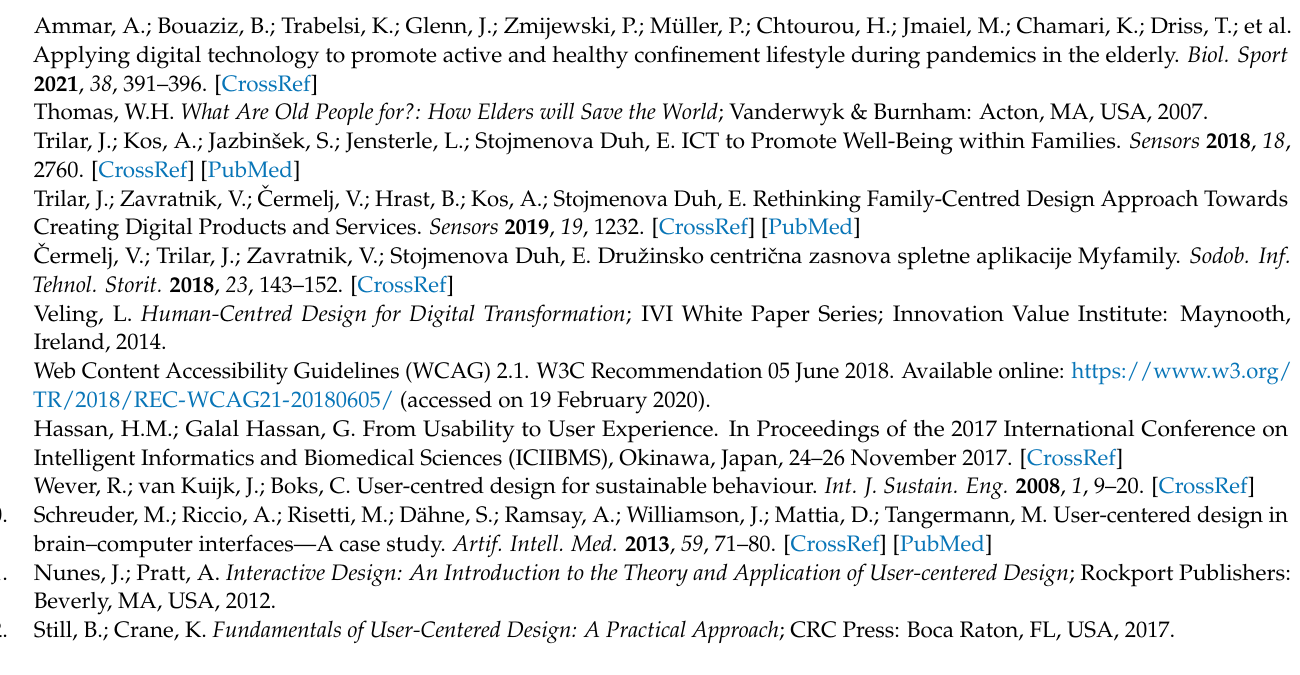
1, Table S26: Success rate by interface for Generation 2, Table S27: Time on task by interface for Generation 2, Table S28: SUS score by interface for Generation 2, Table S29: UEQ results by interface for Generation 2, Table S30: NASA-Task Load results by interface for Generation 2, Table S31: Success rate by generation for Interface 1, Table S32: Time on task by generation for Interface 1, Table S33: SUS score by generation for Interface 1, Table S34: UEQ results by generation for Interface 1, Table S35: NASA-Task Load results by generation for Interface 1, Table S36: Success rate by generation for Interface 2, Table S37: Time on task by generation for Interface 2, Table S38: SUS score by generation for Interface 2, Table S39: UEQ results by generation for Interface 2, Table S40: NASA-Task Load results by generation for Interface